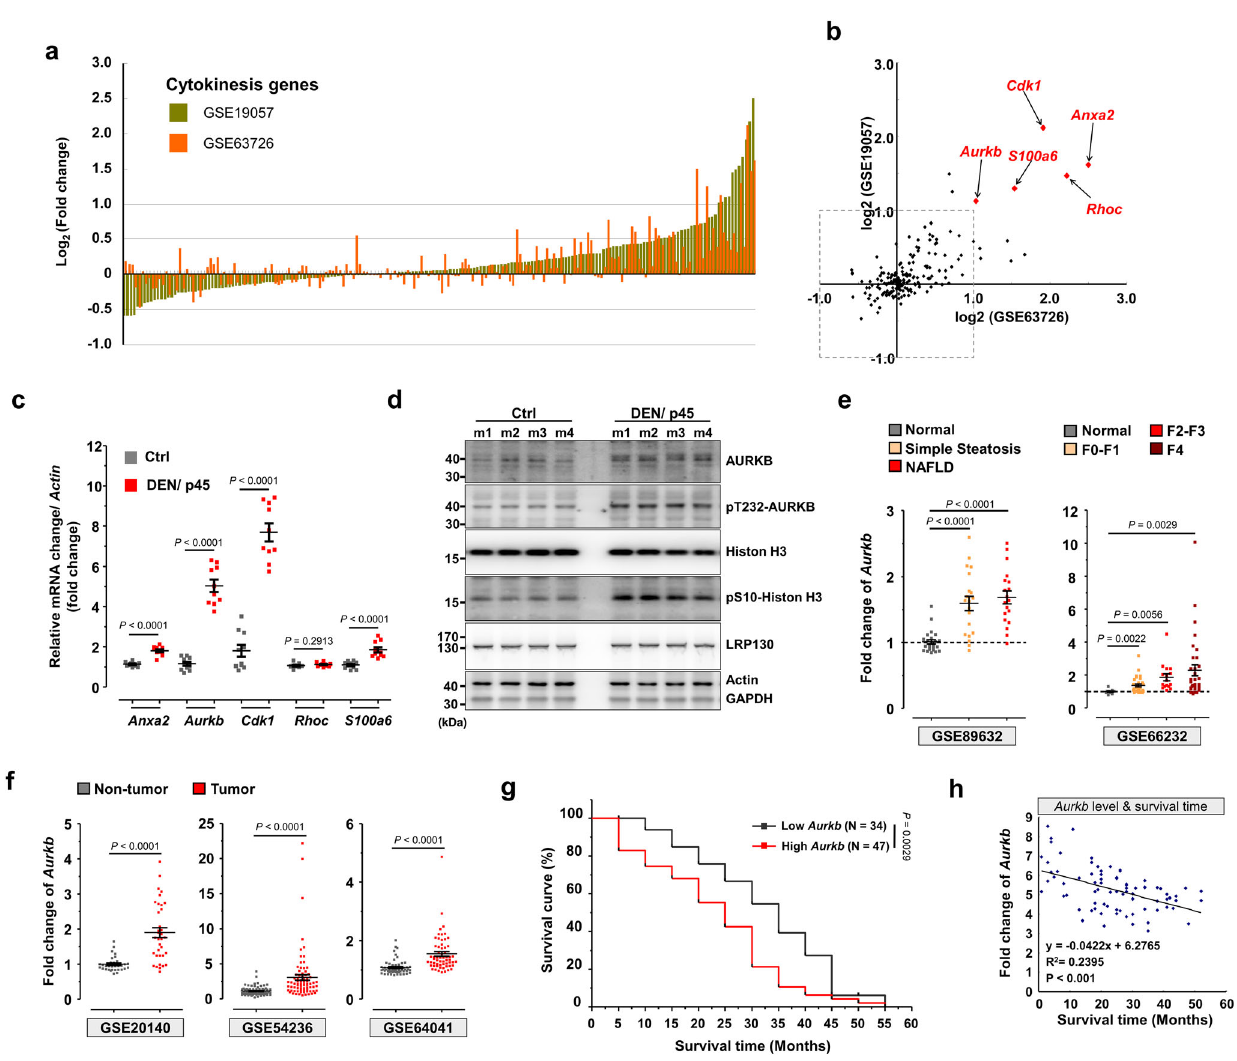
Fig. 4 Upregulation of Aurkb in patients with liver diseases. a The rank order of mRNA expression levels of cytokinesis genes from GEO datasets (GSE19057 and GSE63726). b Scatter plot graph with logarithmic axes shows the top fi ve cytokinesis genes upregulated simultaneously in two GEO datasets. c qPCR analysis of mRNA expression levels of the top fi ve cytokinesis genes in the liver. N = 10 mice/group. d Immunoblot detection of AURKB and pT232-AURKB levels in indicated mouse liver tissues. N = 4 mice/group. e The expression levels of Aurkb from human liver biopsies in GEO datasets. Steatosis and NAFLD patients (left panel), different fi brosis stage of human livers (right panel). Patient numbers: GES89632, N = 24/20/19; GES66232, N = 10/32/16/33. f Human Aurkb expression in tumor and non-tumor biopsies from GEO datasets. Patient numbers: GES20140, N = 34/35; GES54236, N = 80/81; GES64041, N = 60/60. g Kaplan – Meier plots for survival curves of patients with low and high Aurkb expression in the liver. Patient numbers: GES54236, N = 44/37. h The linear regression analysis of the correlation between Aurkb expression and survival time of patients. Each point represents